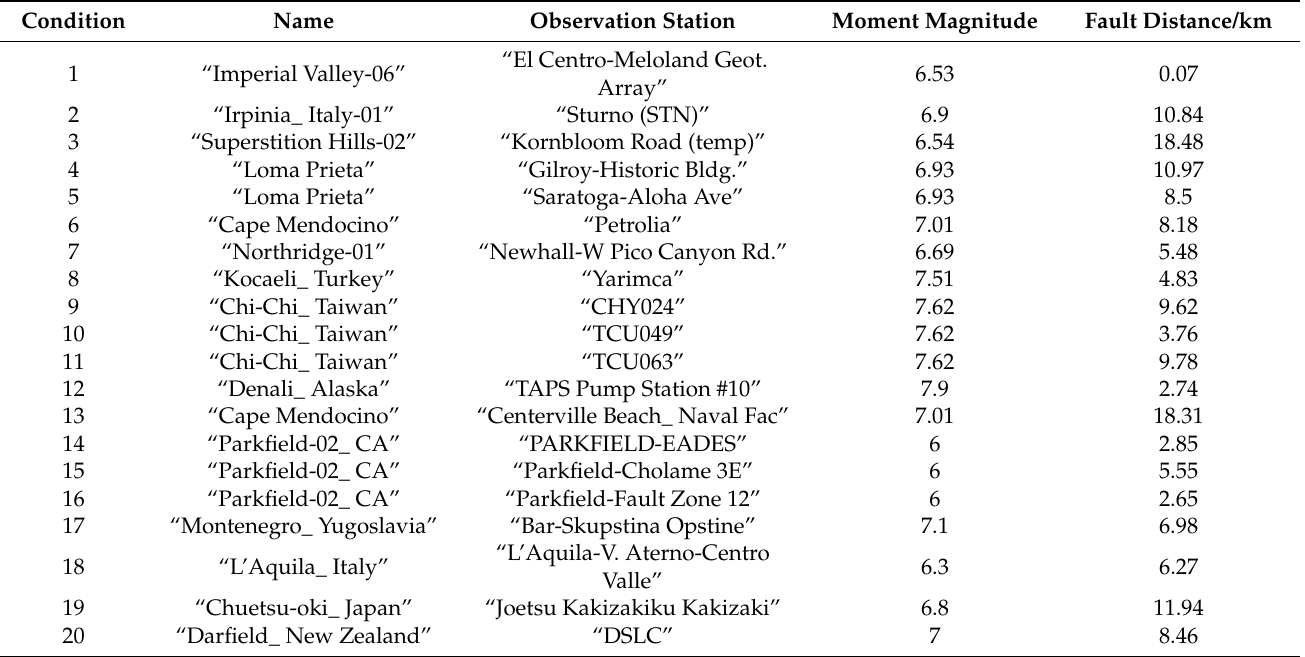
Table 4. Near-site vibration records.